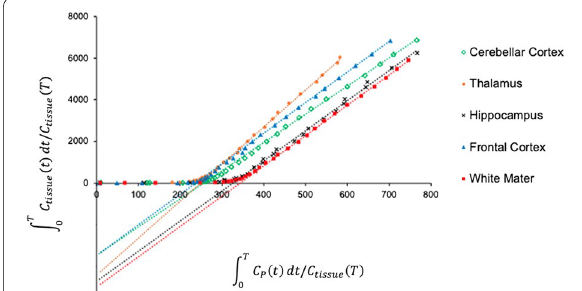
Fig. 3 Representative Logan plots from 90-min 11 C-CPPC PET data across brain regions of interest. Select regional Logan fittings from one healthy participant are shown